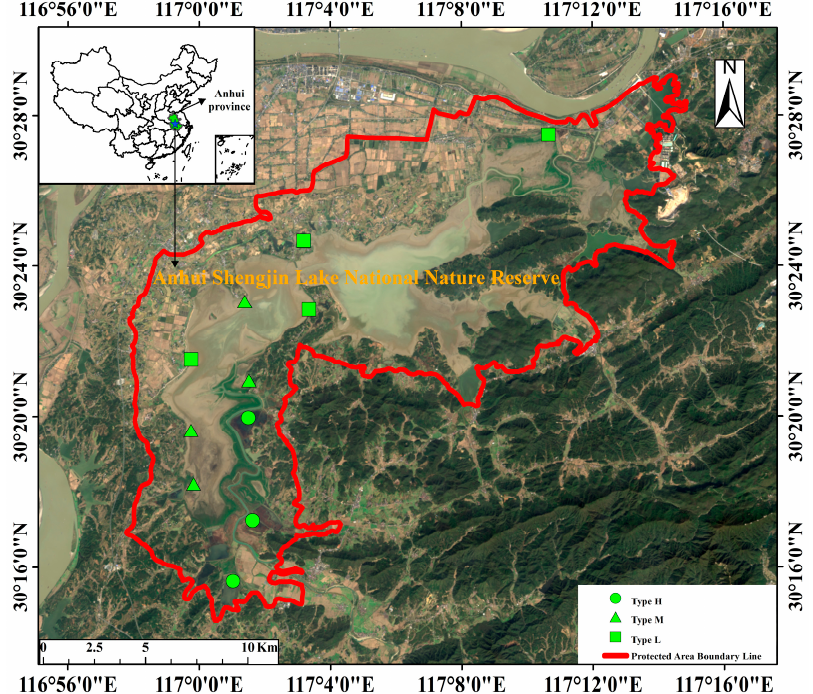
Figure 1. Study area at Shengjin Lake, China. Type H: the Euryale ferox artificial planting area, type M: the Trapa spp. natural growth area, type L: the control